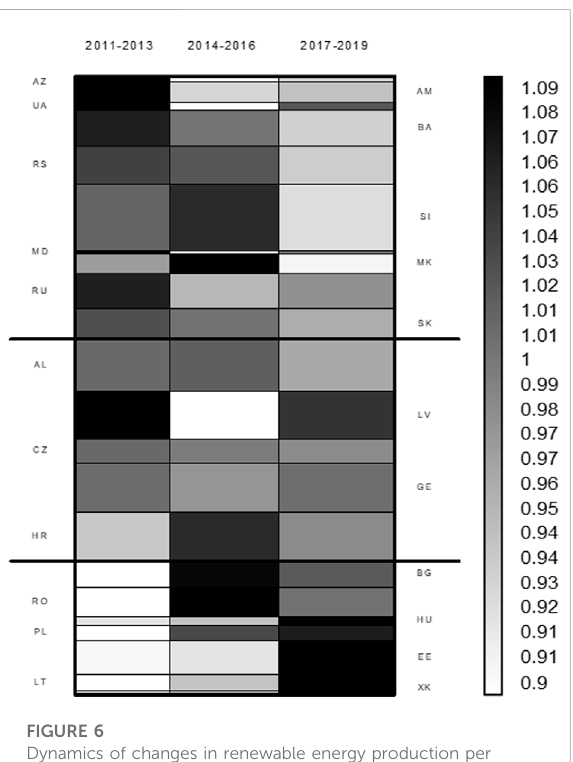
FIGURE 5 Dynamics of changes in renewable energy production in countries of Central and Eastern Europe in 2011 – 2019.